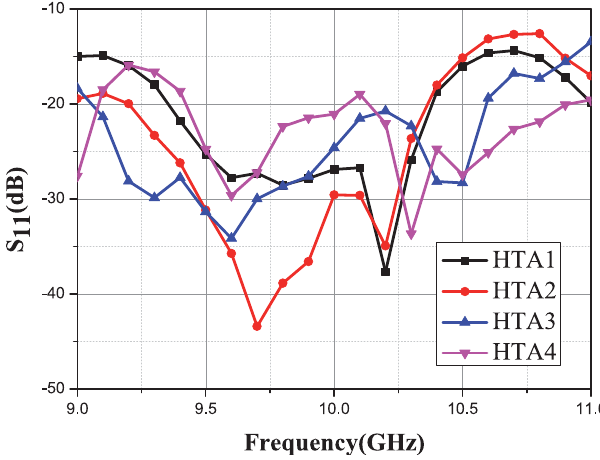
Fig. 9. The re fl ection coef fi cient of four